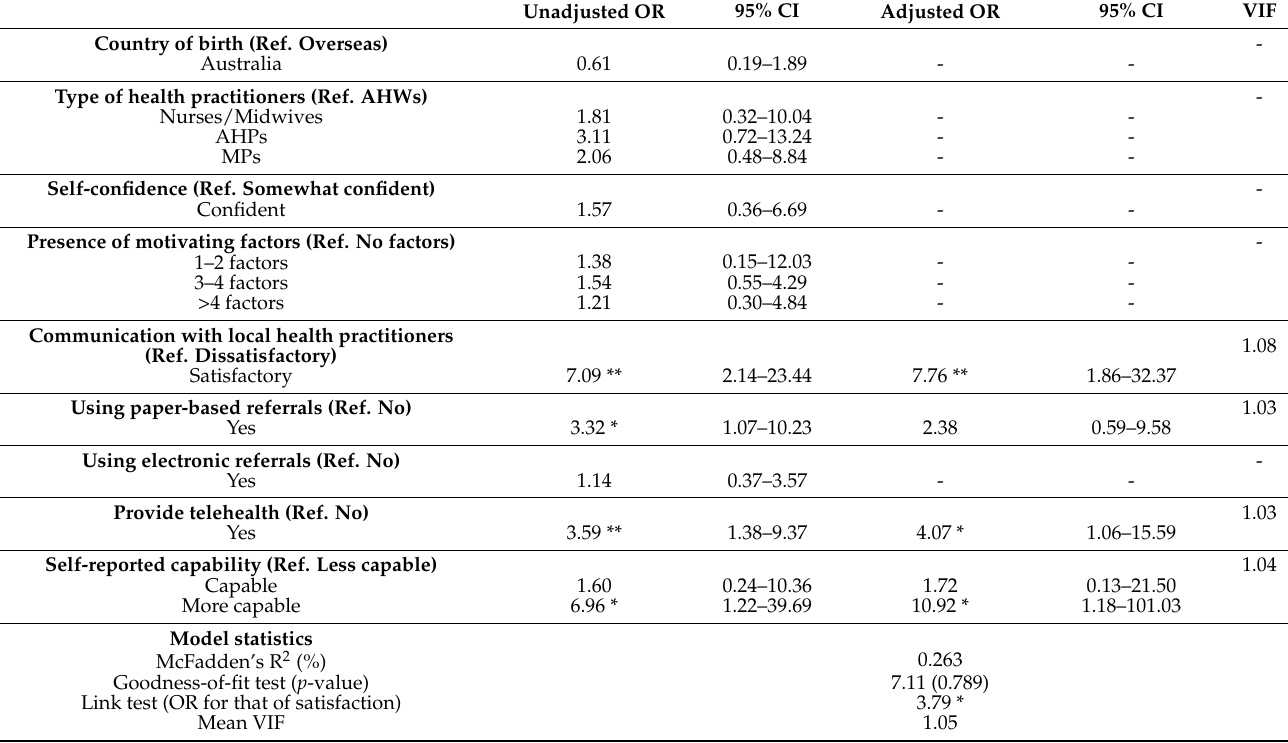
Table 4. Determinants of outreach health practitioners’